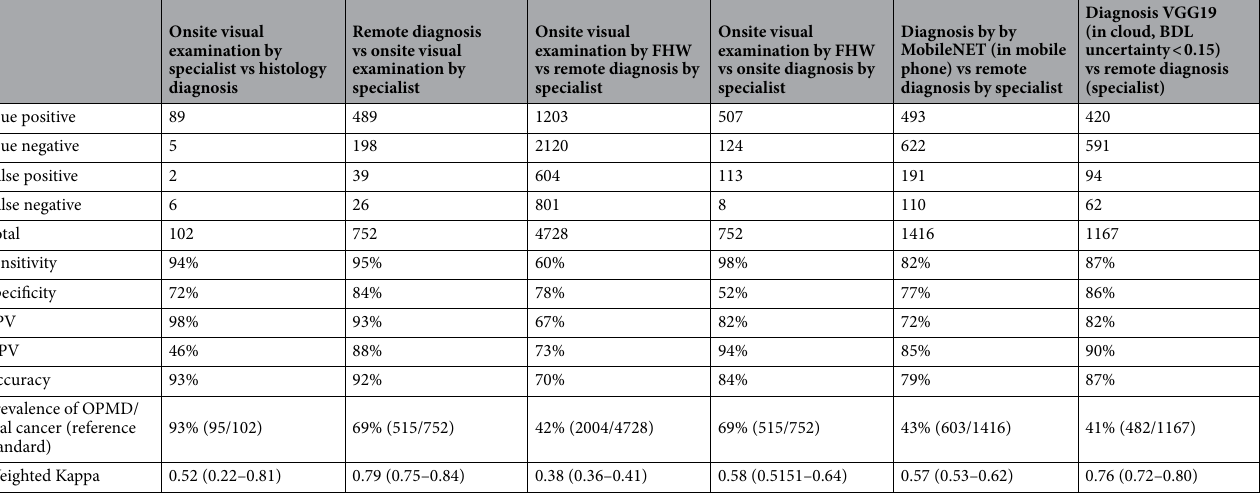
Table 1. Comparison of the different tests according to the reference standard. The table depicts the number of true positives, true negatives, false positives, false negatives, and total cases. The sensitivity, specificity, positive predictive value (PPV), and negative predictive value (NPV), and accuracy were calculated according to the reference standard. The kappa statistics, to find the agreement, was performed between the reference standard and test. OPMD Oral Potentially Malignant Disorders, FHW Front line health